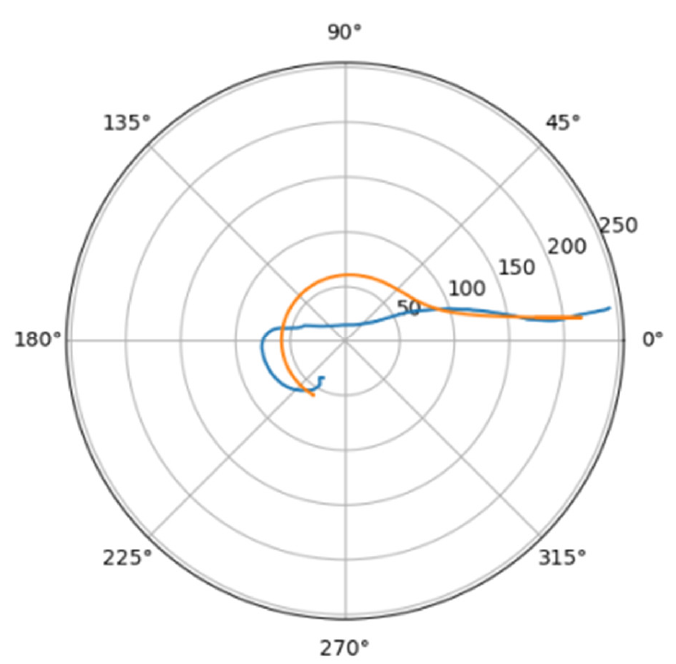
Figure 7. Approximation for are_s.